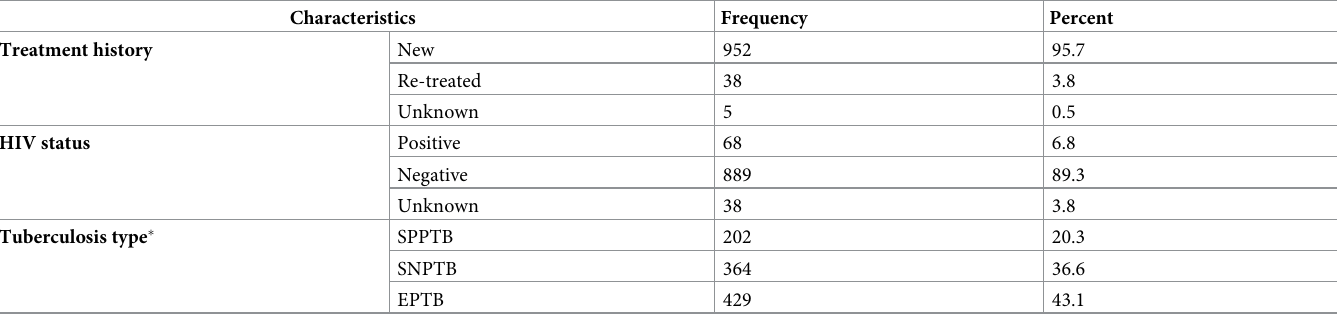
Table 2. Clinical characteristics of TB patients at three TB treatment centers in East Wollega from 2012 to